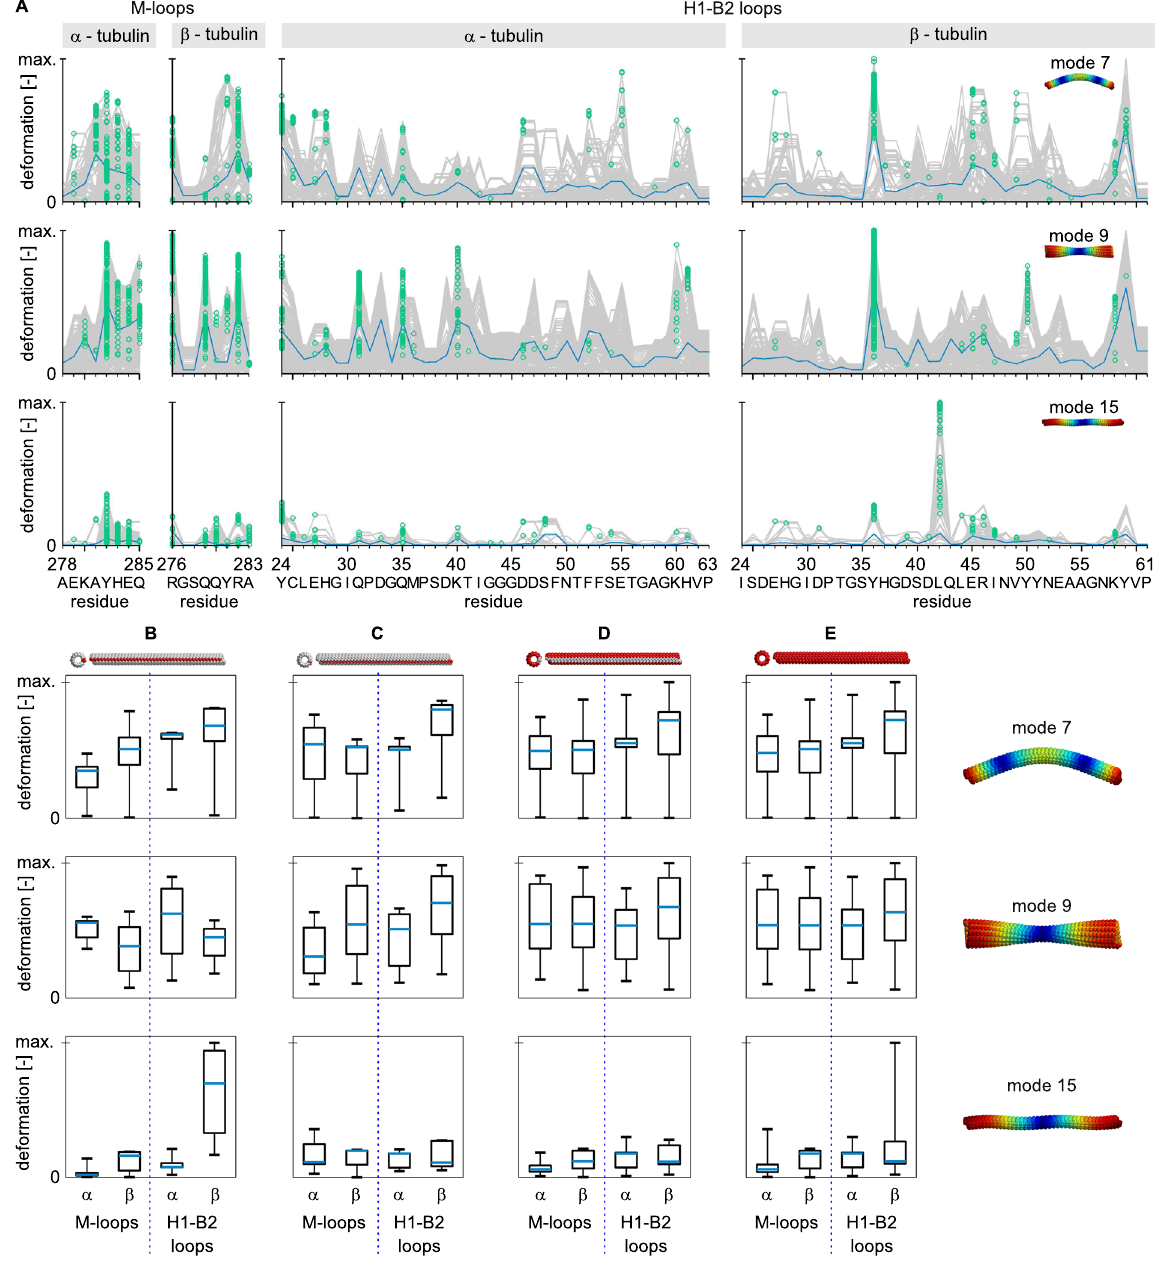
Figure 5. Deformation in lateral contacts for three principal shapes of normal modes. ( A ) absolute vibration- related deformations along residues forming the M-loop and H1-B2 loop within α and β tubulins. Absolute deformations for all tubulin dimers within microtubule (grey) with individual maxima used for box-plots bellow marked by green circles. The blue line shows the average of the absolute value of the deformation. Deformations in M-loops and H1-B2 loops in tubulins in the seam ( B,C ) and far from the seam ( D ) of the microtubule. Overall deformations in these regions are shown in column ( E ). The analyzed protofilaments are indicated in red above each column. The central blue mark in box-plots represents the median, the box represents a region within the 25th and 75th percentiles, and the whiskers represent the maximum extent of absolute deformation. Note that the deformations are normalized to the maximum within the respective vibration mode and that the number of tubulins within the seam is smaller than the number of tubulins not involved in the